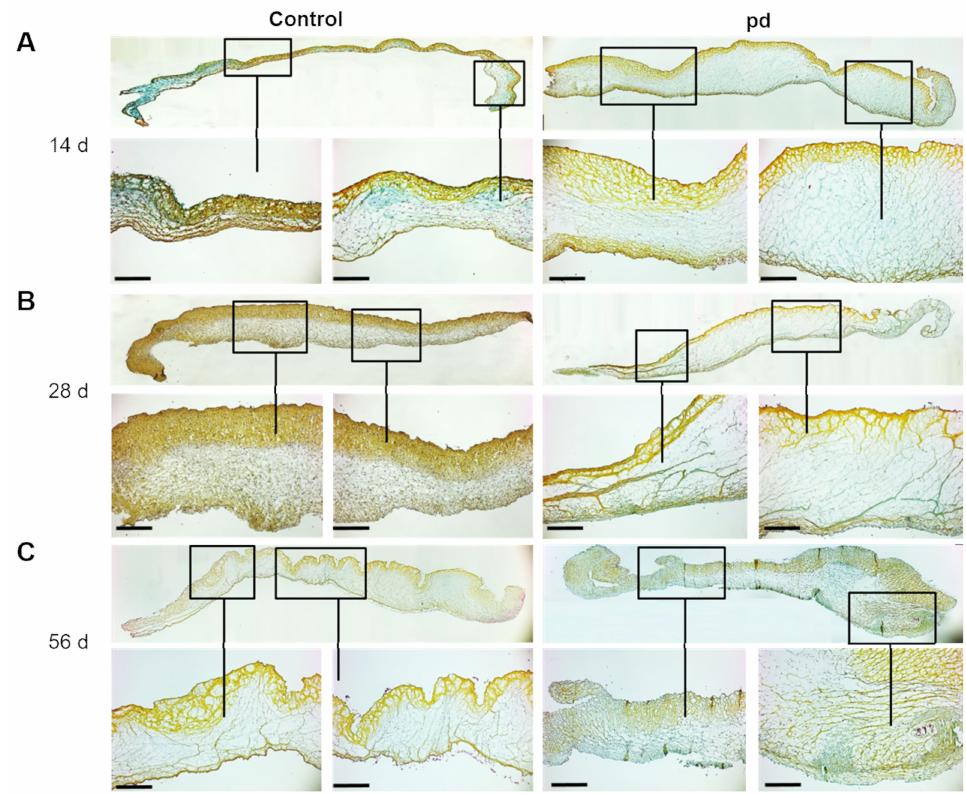
Figure 3. Temporal progression of ECM remodeling of AV leaflets. Movat’s pentachrome staining of AV leaflets under pro-degenerative (pd) conditions ( β -GP + CaCl 2 ) after 14 d ( A ), 28 d ( B ), and 56 d ( C ) compared to control conditions. Scale bar indicates 100 µ m. Representative images of five different experiments are